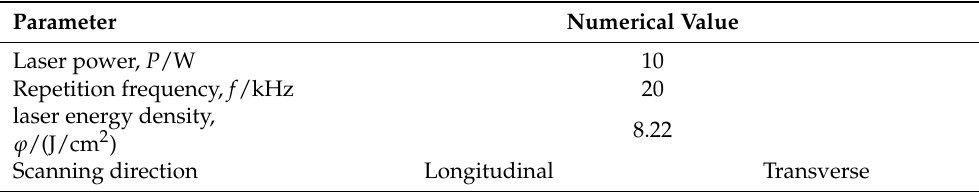
Table 1. Experiment parameters of nanosecond laser grooving (experiment 1, medium energy density grooving).